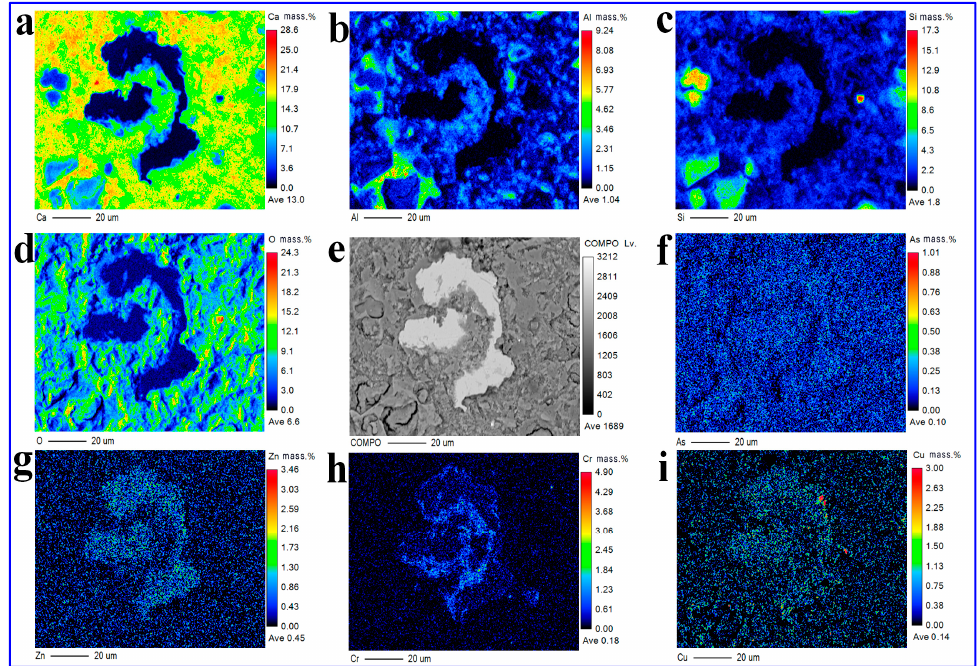
Figure 17. BSE image and elemental distribution of CMM0.5–12 h ( a–i ).